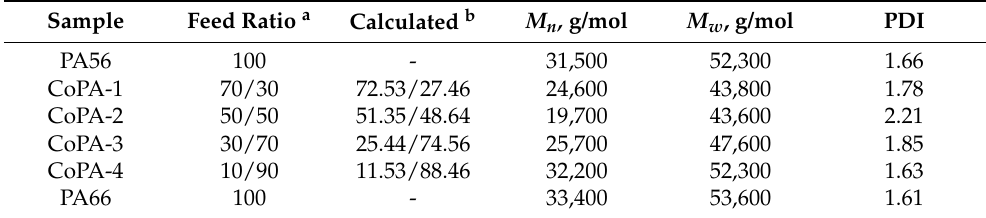
Table 2. 1 H-NMR and Molecular weights of PA56/66 copolyamides.